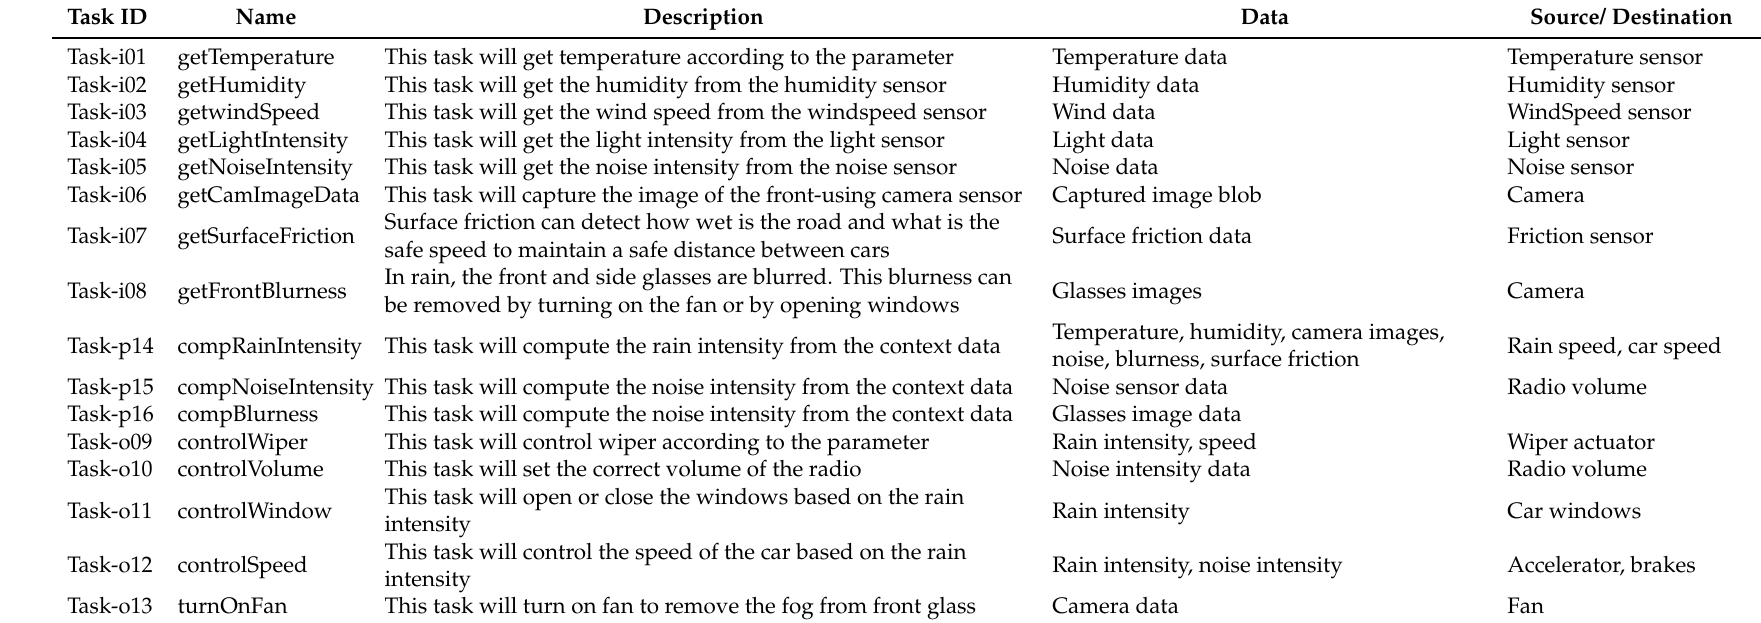
Table 3. Input, process, and output task examples of EV for safe